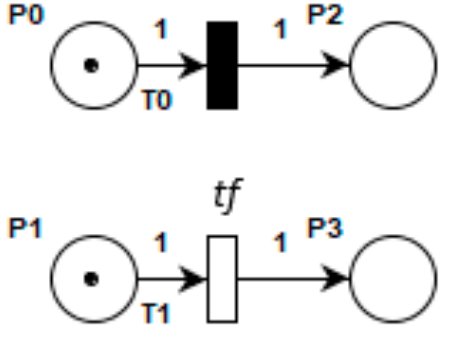
Figure 3. Graphical representation of an immediate (top) and a timed transition (bottom).